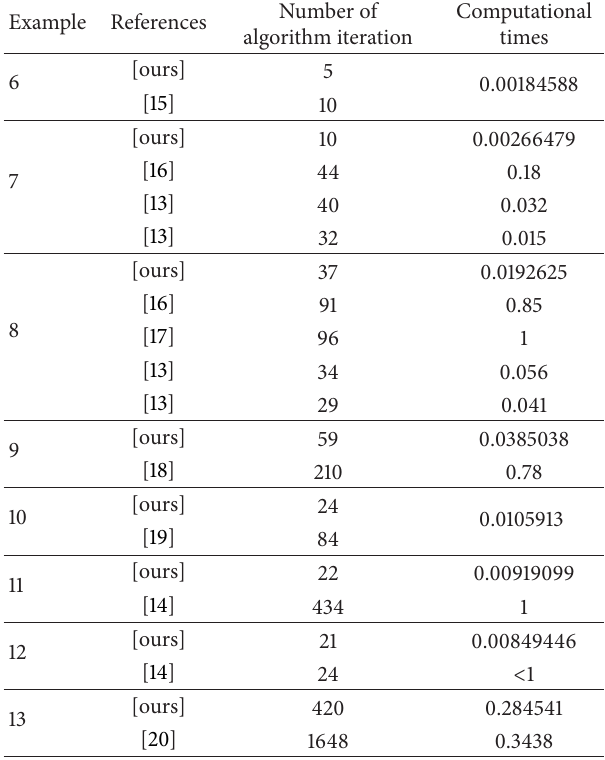
Table 2: Numerical results for the test Examples